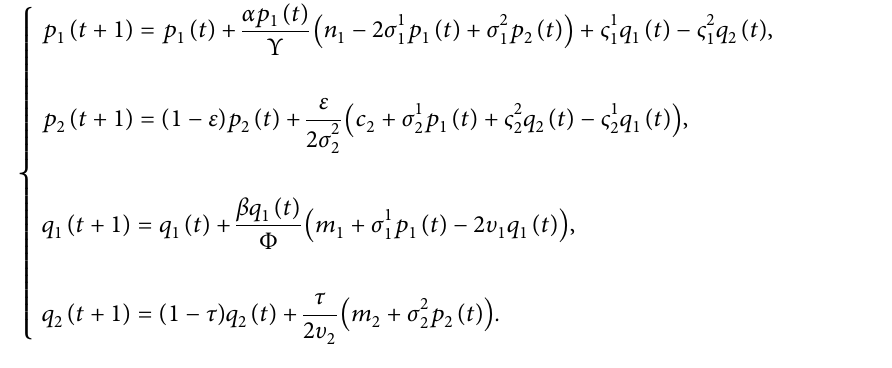
Figure 13: Bifurcation diagrams of q